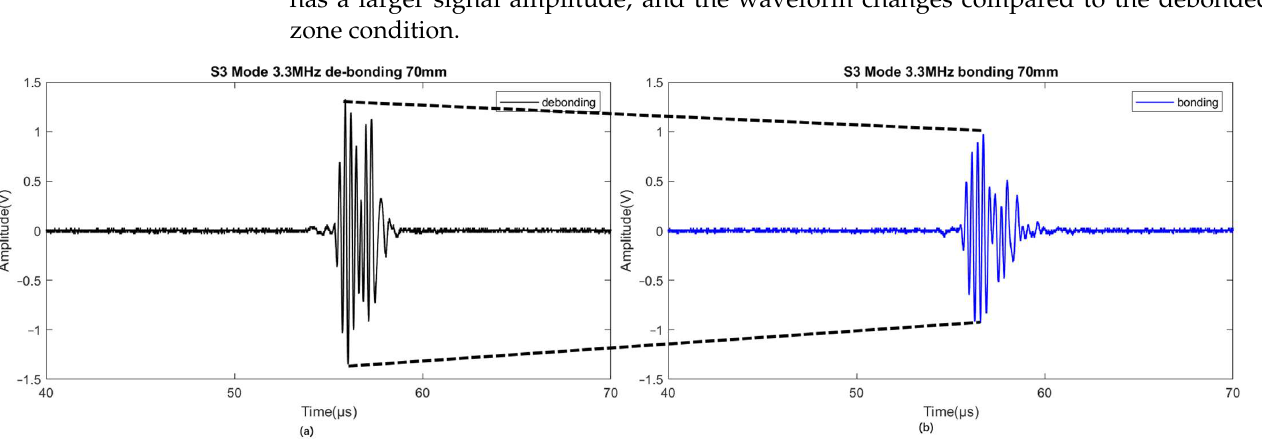
Figure 6. Comparison of the amplitudes of the bonded zone and debonded zone areas for the same propagation distance.